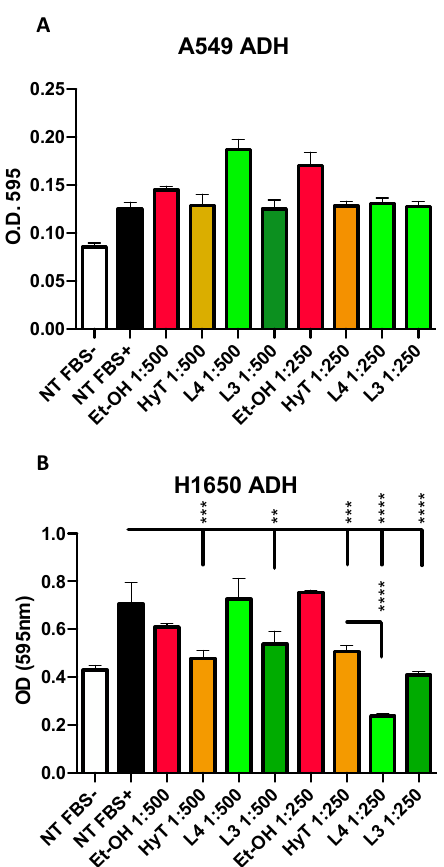
Figure 3. Effect of A009 extracts on cell adhesion in vitro , in lung cancer cells. The lung carcinoma cell lines A549 b(A) and H1650 (B) were pre-treated, for 24 hours, with 2 batches of A009 (L4 and L3), at dilutions 1; 500, 1: 250, or with hydroxytytosol (HyT) at the same concentration present in the dilutions of A009. The effects of A009 on cell adhesion was assessed by seeding pre-treated on a fibronectin layer. Results are shown as mean ± SEM, One Way ANOVA, ** p < 0.01, *** p < 0.001, **** p < 0.0001. NT (untreated); EtOH (ethanol vehicle used to dissolve hydroxytyrosol).